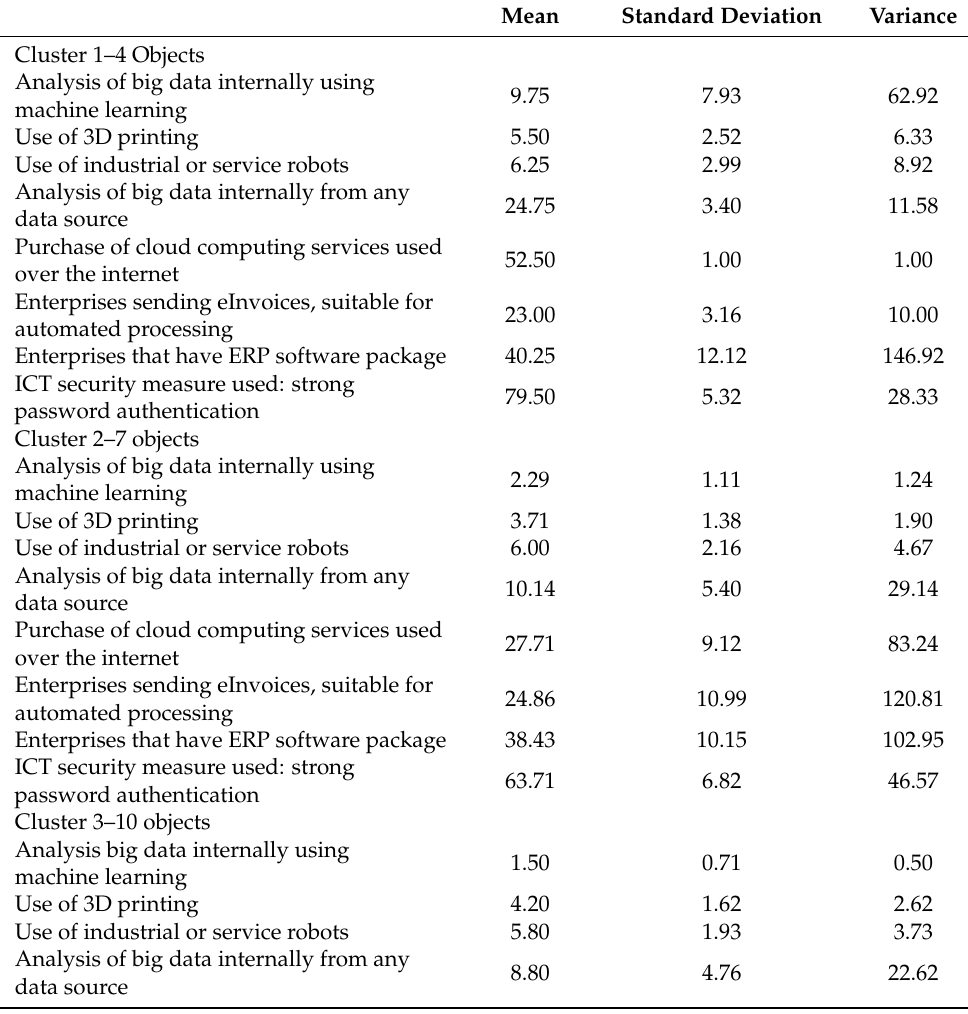
Table 9. Descriptive statistics of